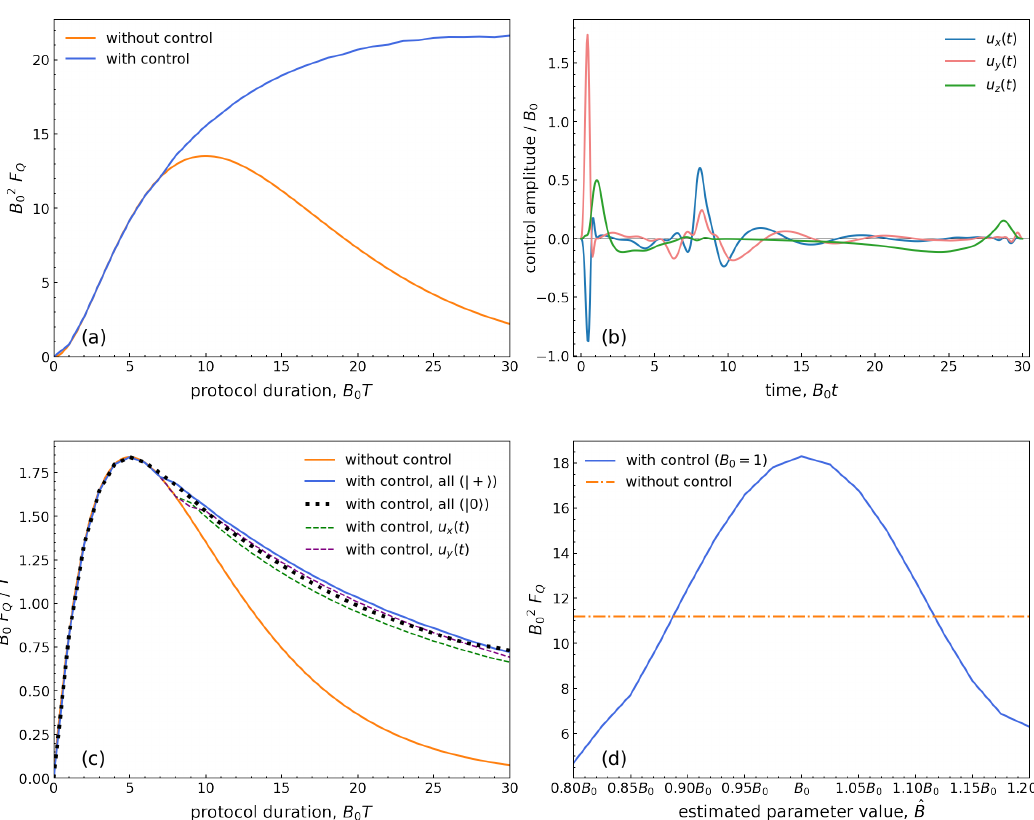
− 2 ) = 1.0 (a) The QFI (in units of B Figure 1: Parallel dephasing, γ = 0.1, B 0 0 achieved without control and with control optimised with different duration T (in − 1 ). (b) Optimal controls obtained using Krotov’s method for the dynam- units of B 0 ics with T = 30. (c) Normalised QFI (by T) without control (orange line), with control in all directions with | + 〉 (purple line) or | 0 〉 (black dotted line) as initial ( t ) (green dashed line) or u ( t ) (red state, and with control restricted to only u x y dashed line). (d) The QFI achieved by applying controls optimised with different estimated parameter values ˆ B on states evolved under the true parameter value. The target time is T = 15. All axes are set to be